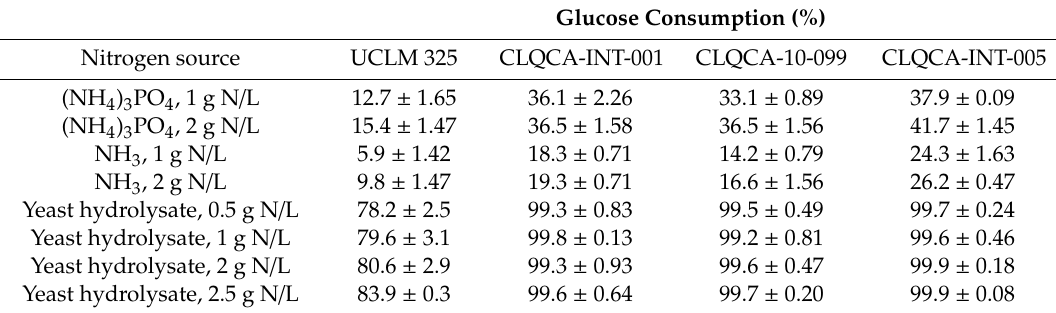
Glucose consumption of di ff erent Saccharomyces cerevisiae strains: